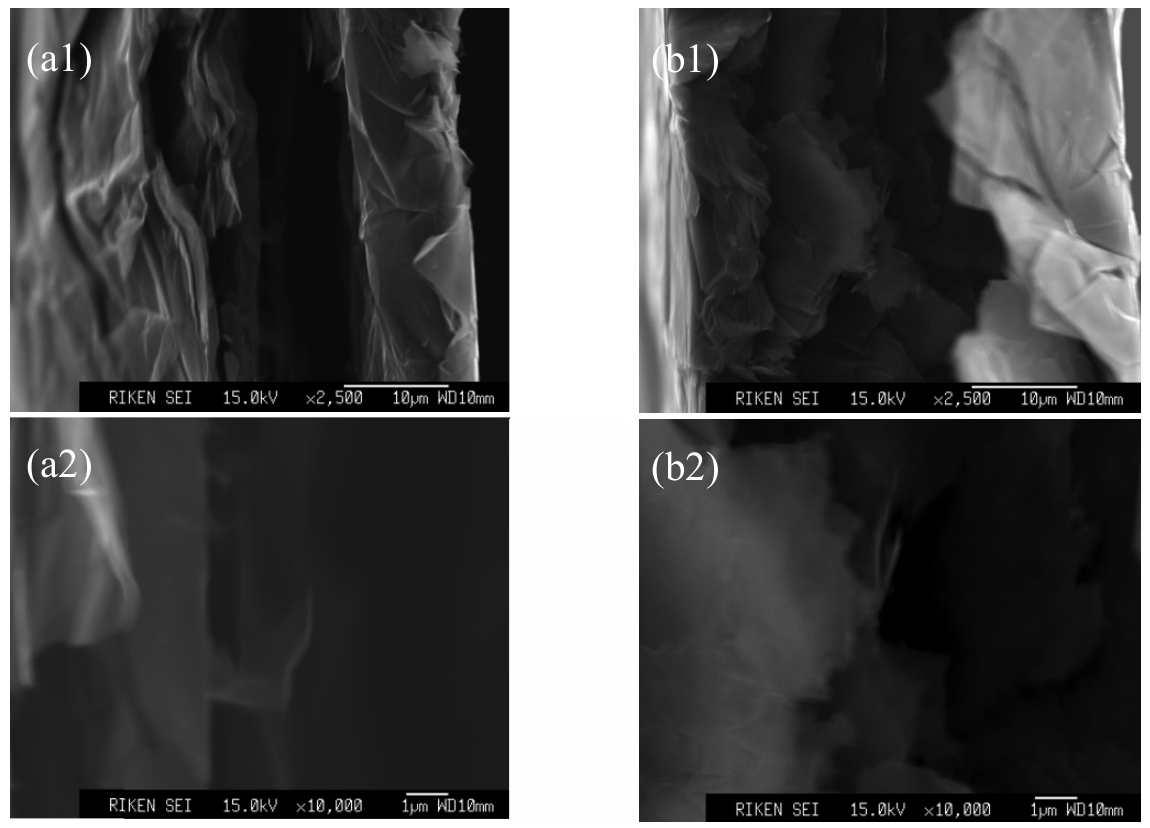
Fig. 4a. SEM images of the GS cross-section. (a1) and (a2): no-irradiated part.